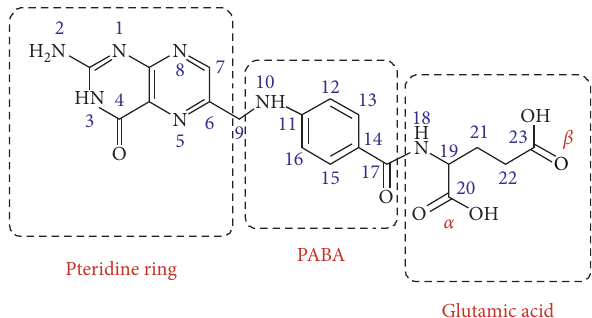
Figure 1: Structure of folic acid (FAH